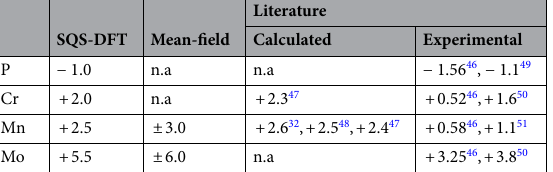
Table 2. Computed relaxation volumes Δ V (Å 3 ): SQS-DFT, mean-field approach and literature data.